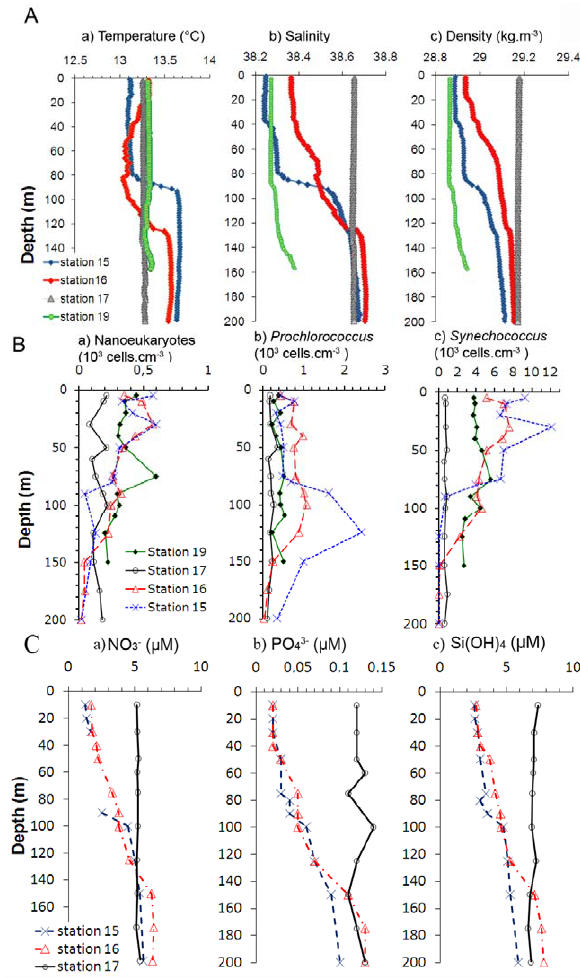
Fig. 4: Southern Adriatic basin features. A: Profiles of (a) temperature, (b) salinity, and (c) density excess for the stations located in the southern Adriatic basin and in the Strait of Otranto. B: Vertical distribution of (a) Nanoeukaryotes, (b) Prochlorococcus and (c) Synechococcus in the southern Adriatic basin and in the Strait of Otranto. (Note that different scales of abundance are used for the sake of the presentation). C: Vertical distribution of (a) Nitrate (NO 3- ), (b) Phosphate (PO 43- ) and (c) Silicate (Si(OH) 4 ) in the southern Adriatic basin and in the Strait of Otranto. Station 19 was not available. Fig. 5: Relationships between vertical distributions of Synechococcus abundance and density inside (station 17) and outside (station15) the south Adriatic gyre. (A) Depth dependence of the density ratio Syn 17 /Syn 15 . (B) Depth dependence of the abundance ratio σ 17 / σ 15 . (C) Relationship between Synechococcus abundance ratio Syn 17 /Syn 15 and density ratio σ 17 / σ 15 . Data belonging to the upper 50 m (empty triangles) were excluded from the relationships (filled triangles).